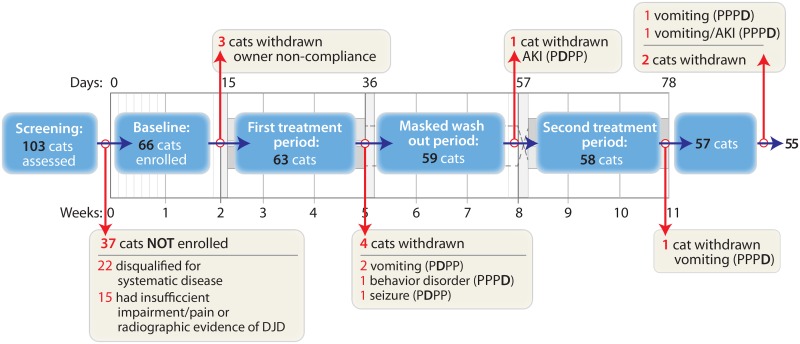
Participant flow diagram.Events occurring at each time point are outlined below. Cats removed from the efficacy analysis were retained for the safety analysis, unless otherwise noted. Cats are designated by the group they were part of (PDPP [meloxicam first] or PPPD [placebo first]).